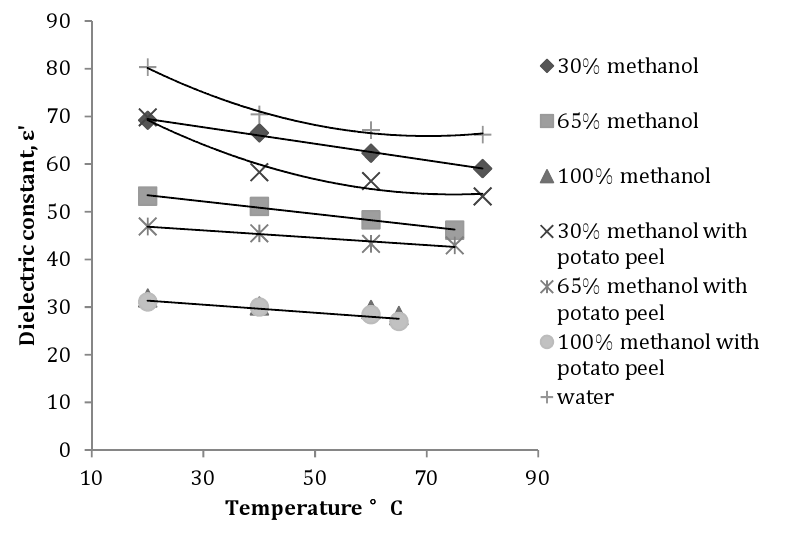
Figure 4. Variation in the dielectric constant of a methanol-water mixture with and without potato peel at 915 MHz (Source: Adapted from [9]).